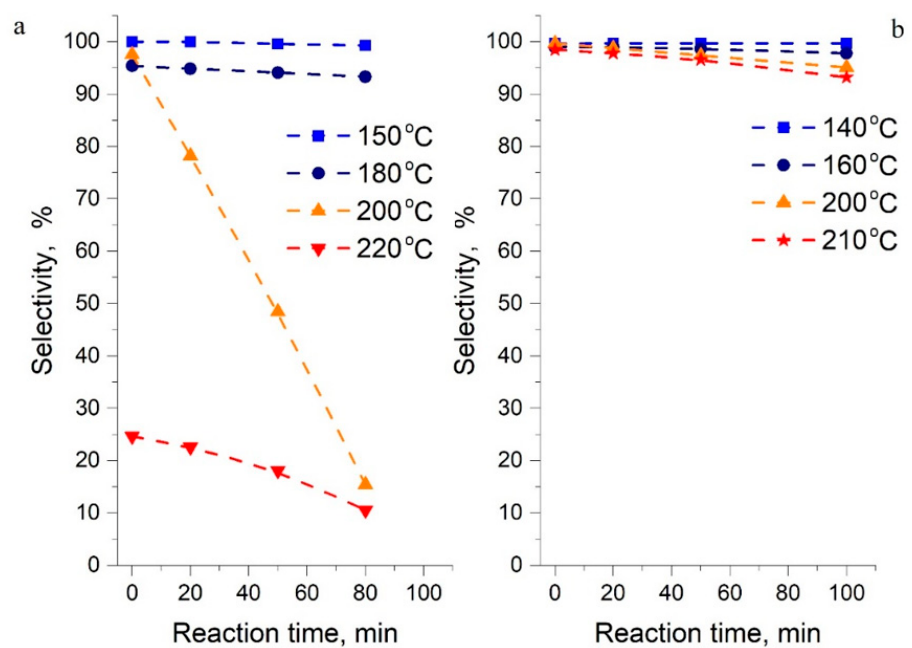
Figure 7. Selectivity in the direction of hydrogenation–dehydrogenation: indoline [1] ( a ) and 1- methylindole ( b ). Selectivity for 1-methyl-indole and its non-decomposed (i.e., partially hydrogenated derivatives) in cyclical hydrogenation–dehydrogenation reactions.